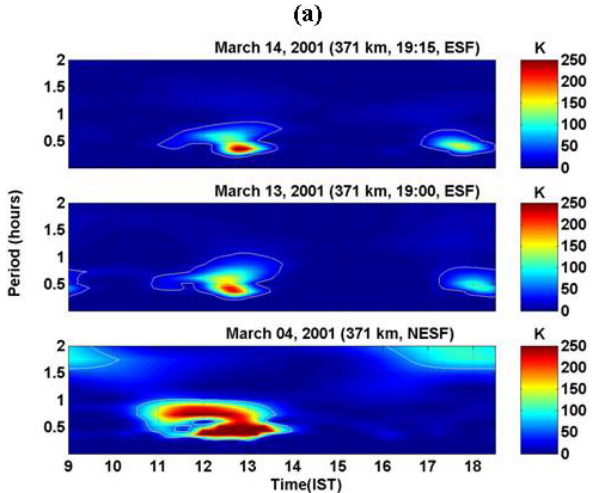
Fig. 2a. Wavelet periodogram of the mesopause temperature for the same days as shown in Fig. 1a. The white solid contours denote the regions of the wavelet spectrum above the 95% confidence level.